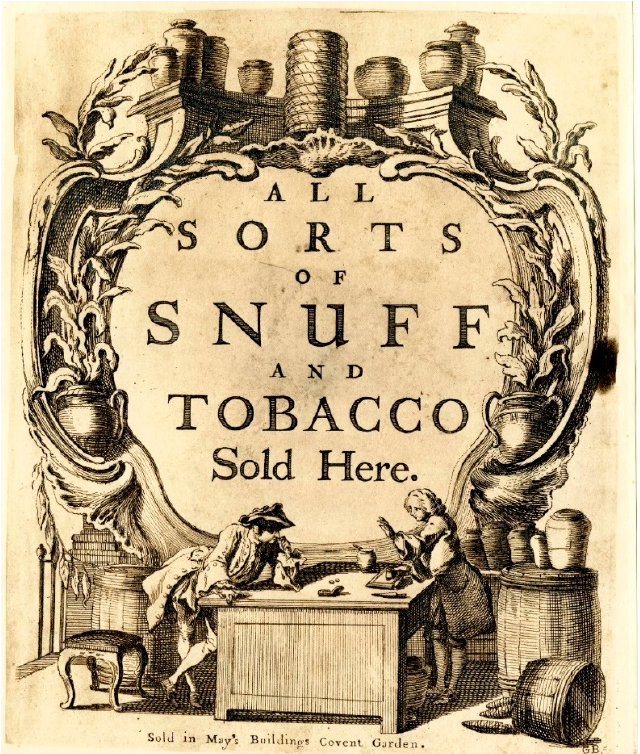
Figure 5. Trade card for May, tobacco and snuff seller. Eighteenth century (Heal, 117.115). © The Trustees of the British Museum.